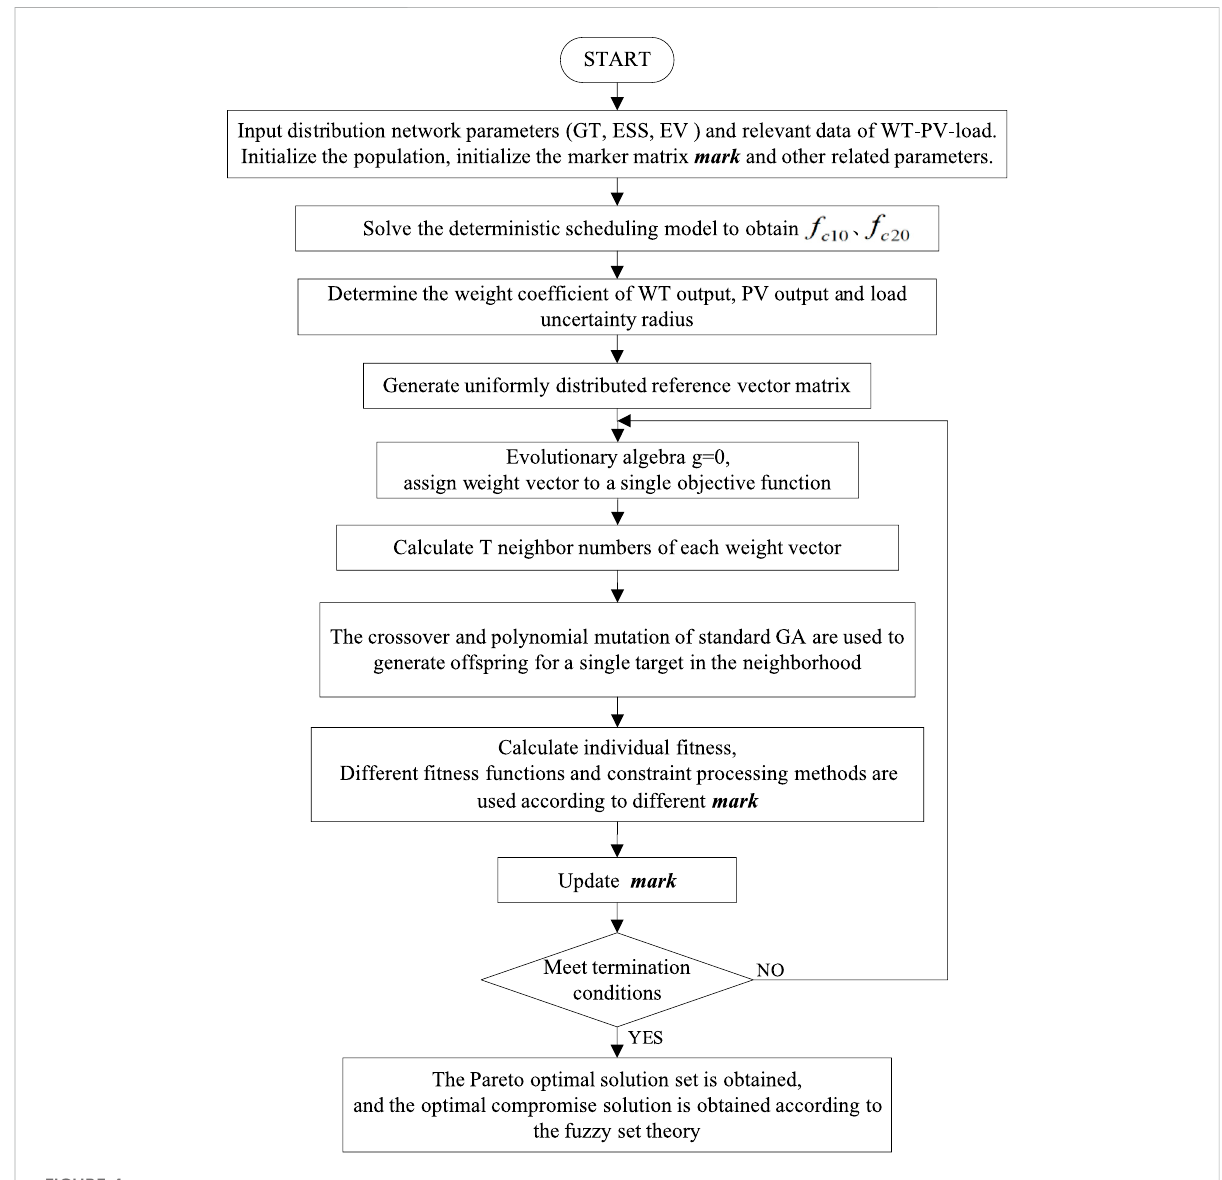
FIGURE 4 Flow of adaptive reference vector based constrained-MOEA for